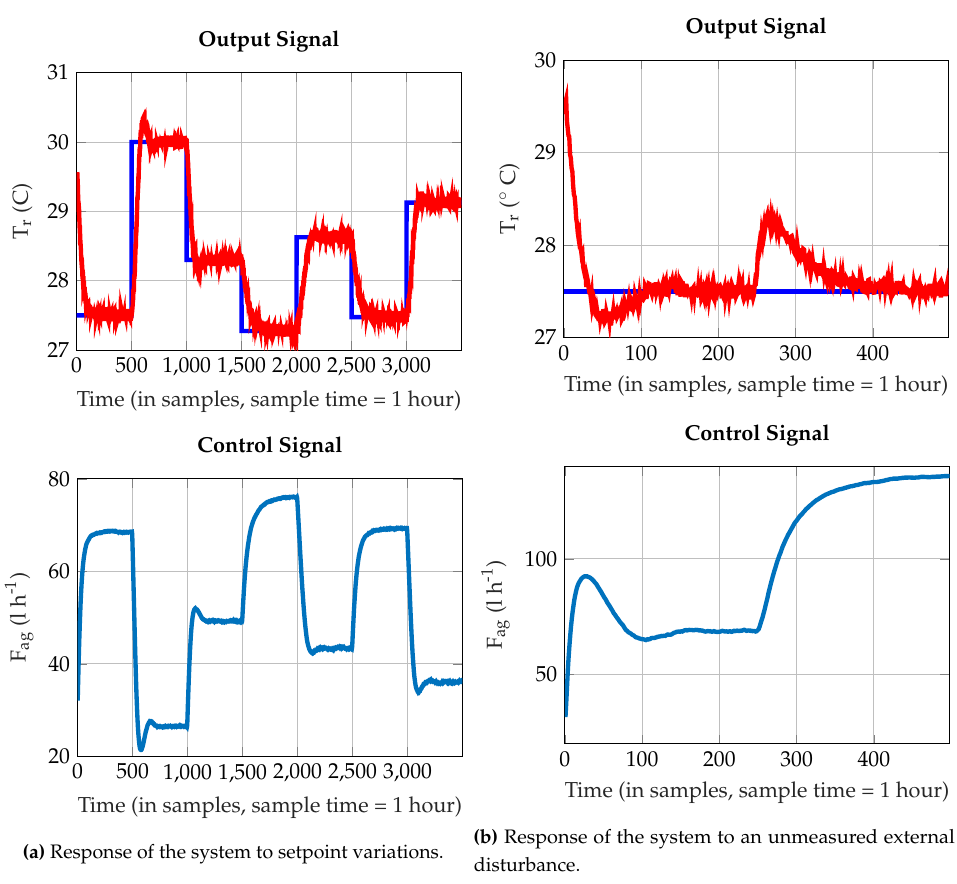
Figure 12. Influence of the parameter ρ (Control action attenuation factor) in the dynamic behavior of the control system.